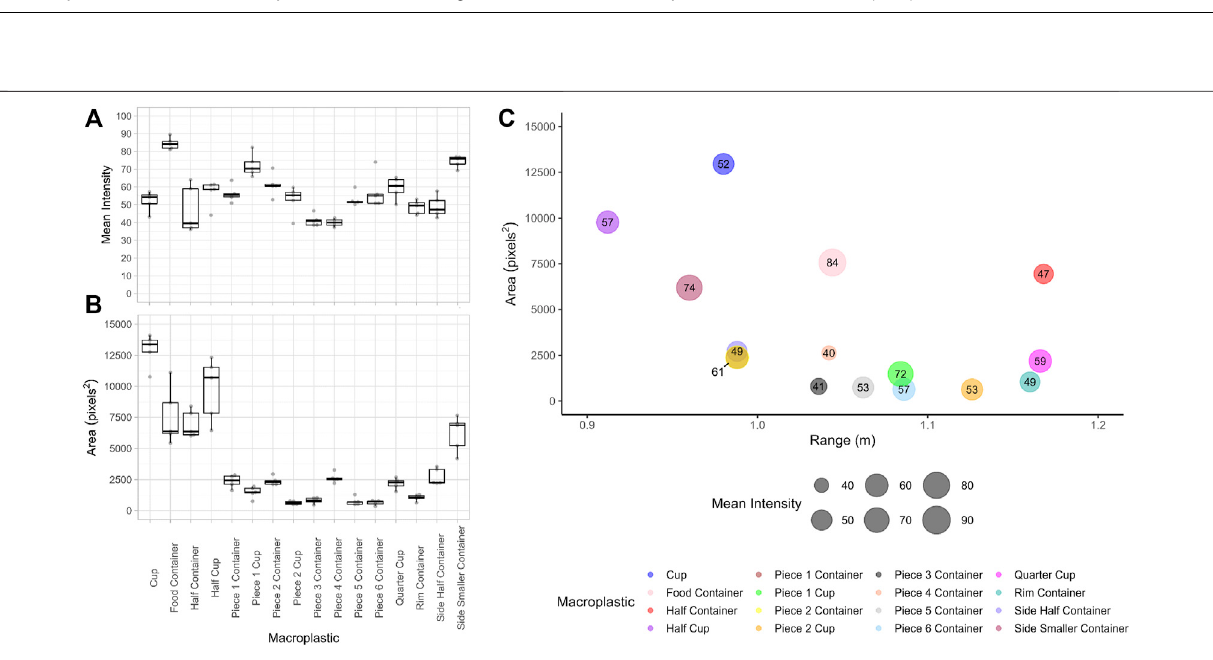
Frontiers in Environmental Science |